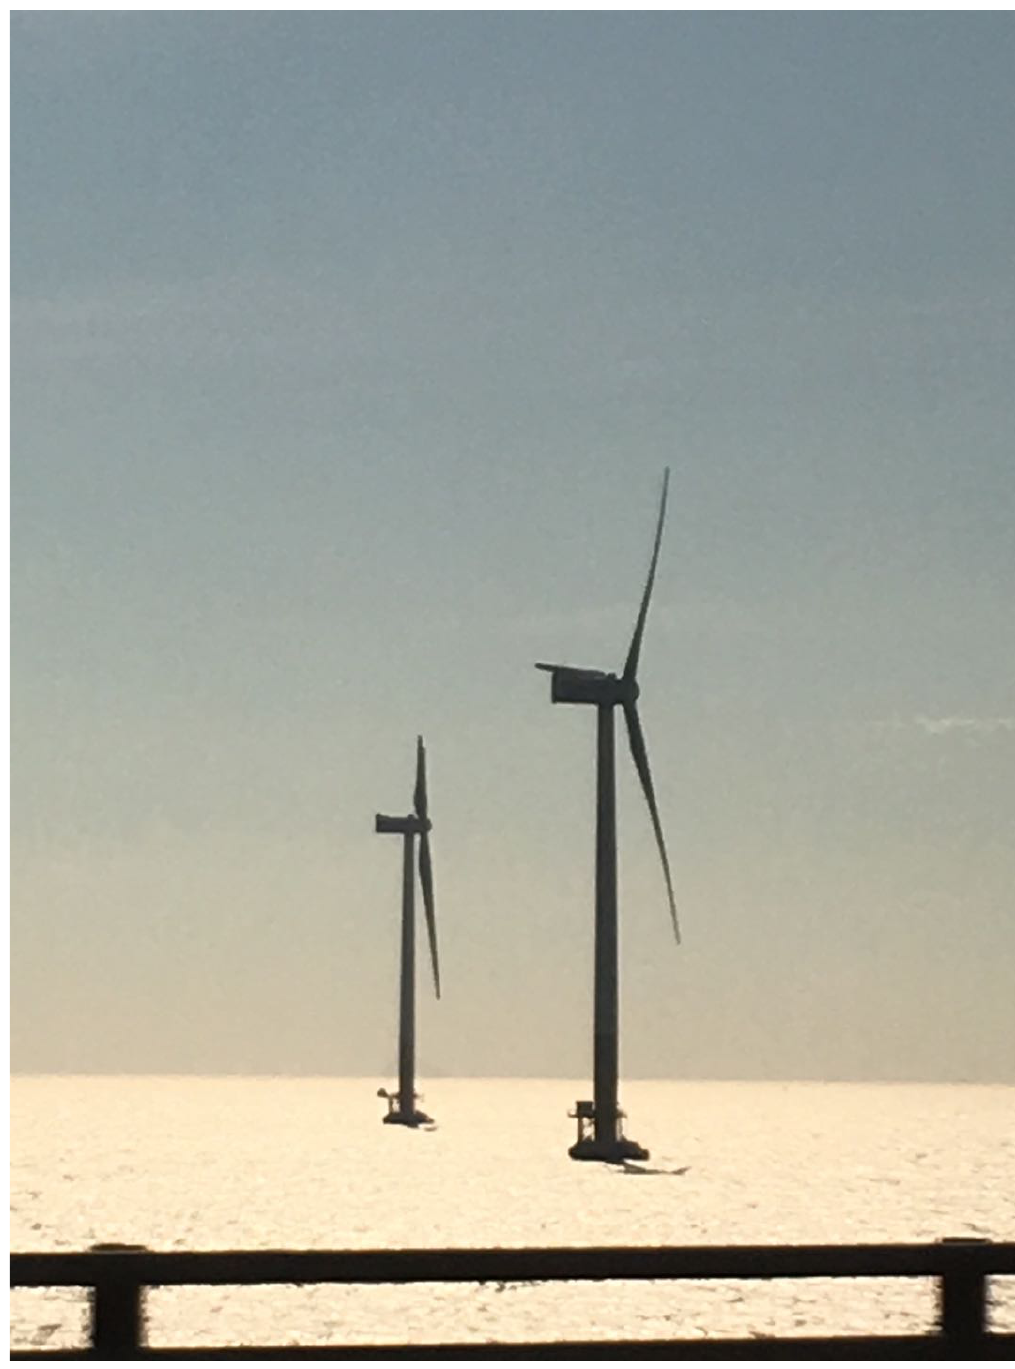
Figure 1. China’s first off-shore wind farm in Yangshan